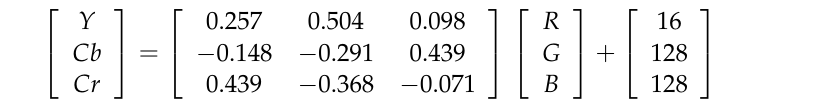
( f ) Figure 4. Histogram statistic: ( a – c ) are the results of Figure 3e–g and ( d – f ) are the results of the red polygons in Figure 3e– g. The first column is the result from T YCbCr ; the second column is the result of SI; and the third column is the result of ISI.